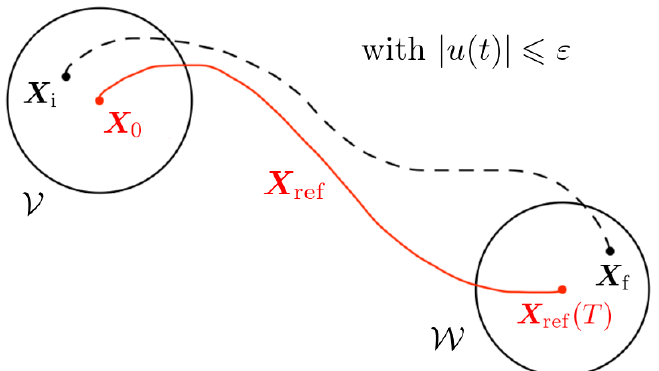
Figure 2. Schematic representation of local controllability around a reference trajectory X ref , in which the swimmer moves along the dashed trajectory between the neighbourhoods V and W whilst the control u ( t ) is kept small. Informally, the system is locally controllable around the trajectory X ref if such a dashed trajectory joining X i and X f exists for all states X i ∈ V and X f ∈ W